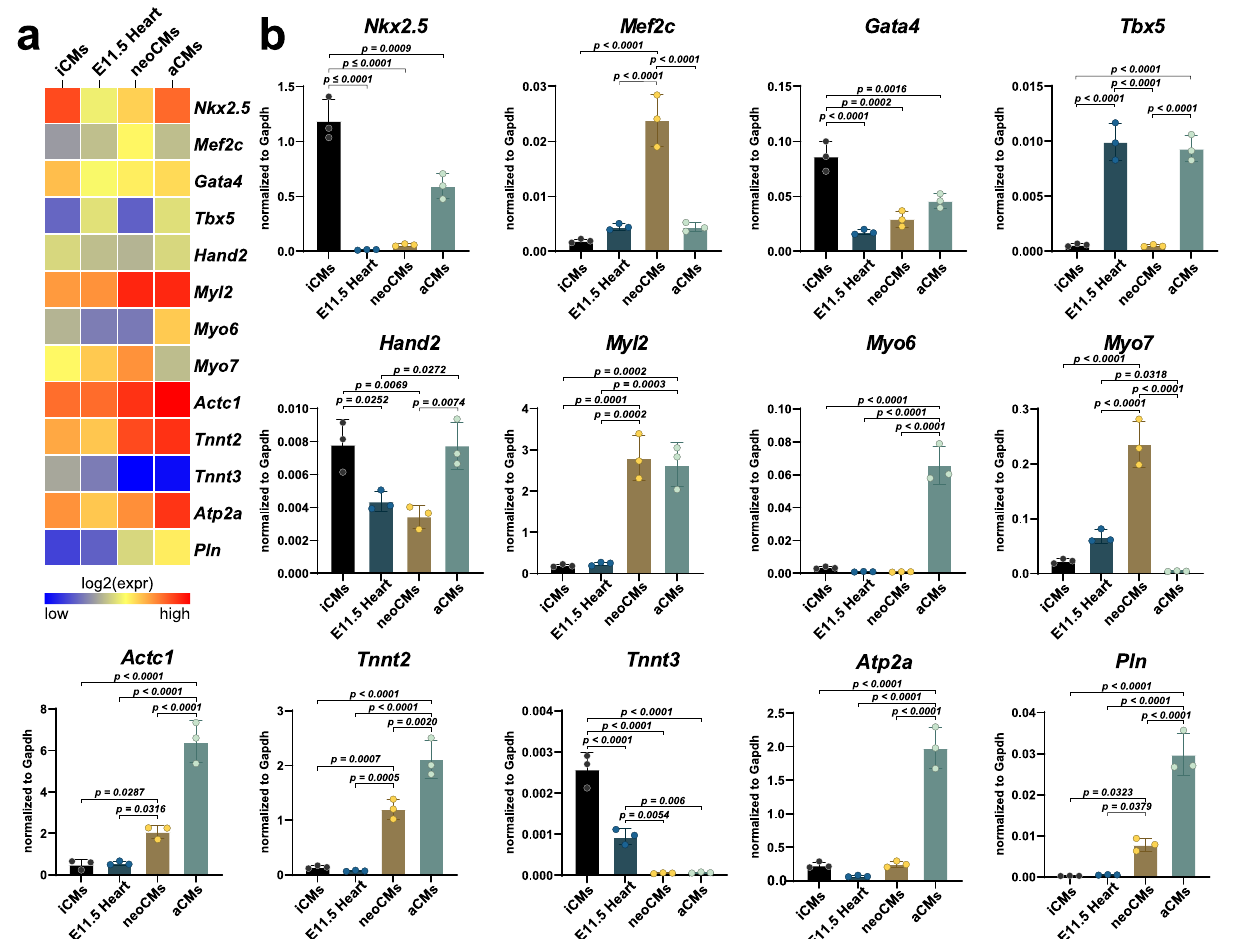
Fig. 2 iCMs reach a biochemical myogenic differentiation level that is intermediate between fetal and neonatal CMs. Heatmap ( a ) and bar graphs ( b ) showing the cumulative qPCR data for the expression of the main cardiac transcription factors Gata-4, Nkx2.5, Mef2c, and Hand2 and the contractile genes Tnnt2, Myl2, Myh7, and Actc1 in iCMs, myocardium from 11.5 embryonic day, neoCMs and aCMs. The data are expressed as mean ± S.D. of biological triplicates. Each of the biological triplicates was veri fi ed by a technical